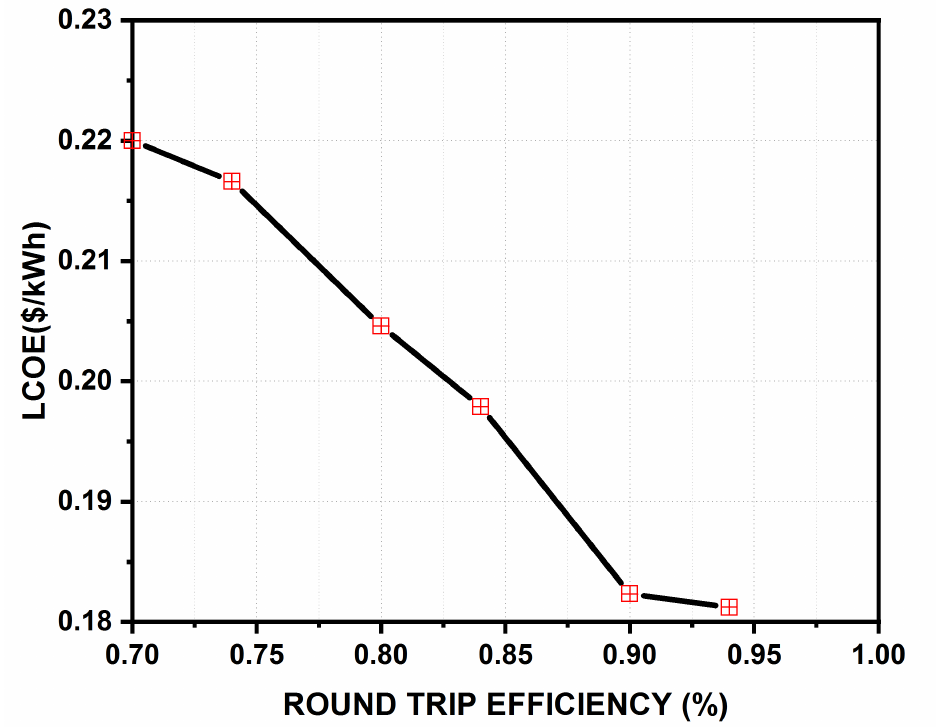
Figure 11. Variation in LCOE of the system with battery round trip